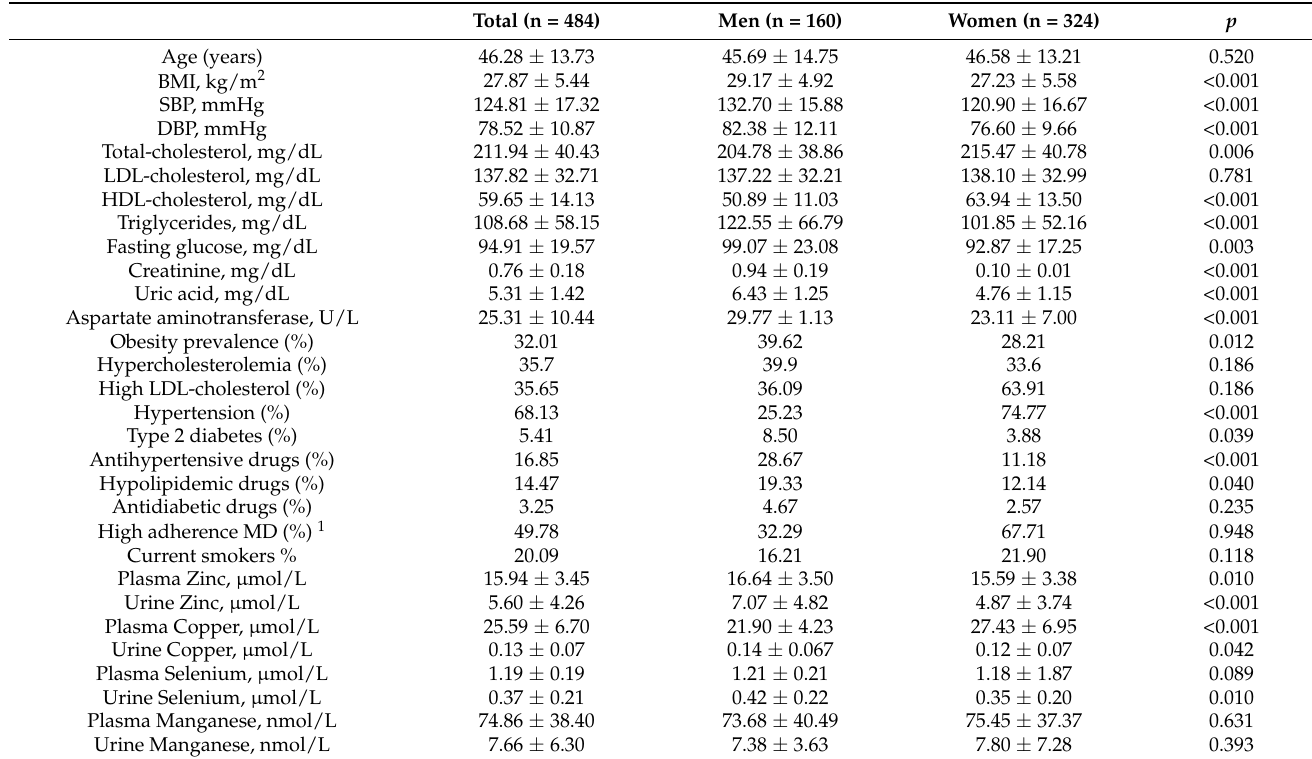
Table 1. General characteristics of the study population by